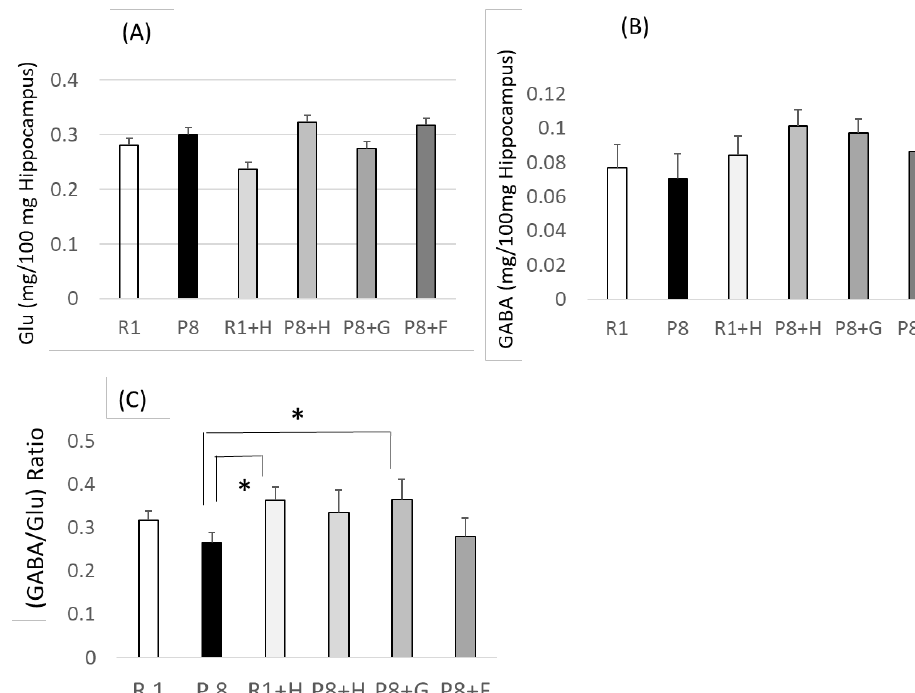
Figure 5. Effect of dietary peanuts and ferulic acid on hippocampus glutamic acid ( A ) and GABA ( B ) contents, and on (GABA/Glutamic acd) ratio ( C ) in SAMR1 and SAMP8. R1: senescence-accelerated resistant mice (SAM-R1) group fed with basal diet; P8: senescence-accelerated mouse prone/8 (SAMP8) group fed with basal diet; R1 + H: SAM-R1 group fed with basal diet with added peanut wholegrain; P8 + H: SAMP8 group fed with basal diet with added peanut wholegrains; P8 + G: SAMP8 group fed with basal diet with added germ-rich fraction of wholegrain; P8 + F: SAMP8 group fed with basal diet with added ferulic acid. * significantly different when compared by Student’s t -test ( p < 0.05).